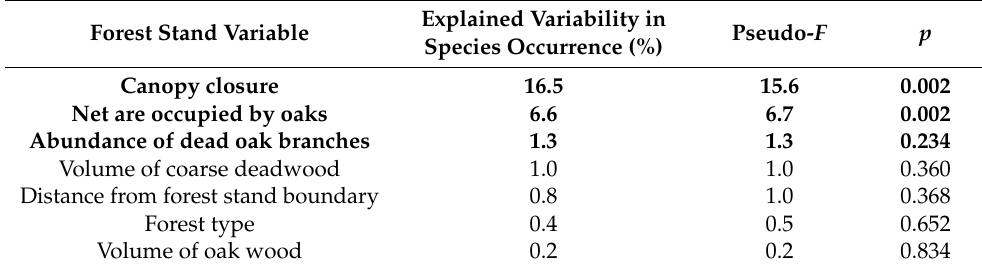
Table 2. Results of the partial redundancy analysis forward selection of the percentage of variability in ambrosia species occurrence explained by the indicated forest stand variables. Conditional effects of the explanatory variables are shown. Effect of the date of trap deployment was removed by considering it as a covariable. The upper three explanatory variables highlighted in bold were included in the model based on the results of the forward selection process. Although it was not statistically significant, the abundance of dead oak branches was included in the model because it helped explain the variability in the occurrence of the species. Explained Variability in Pseudo- F Forest Stand Variable Species Occurrence (%)